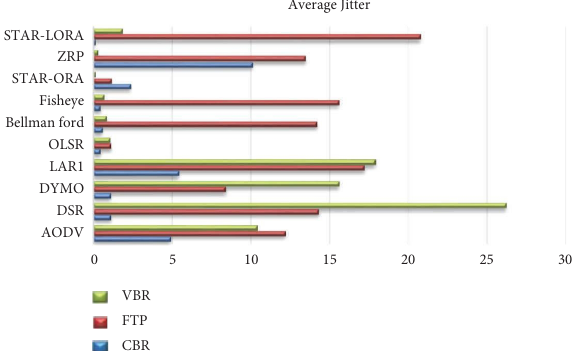
Figure 20: Average jitter of all routing protocols for 60